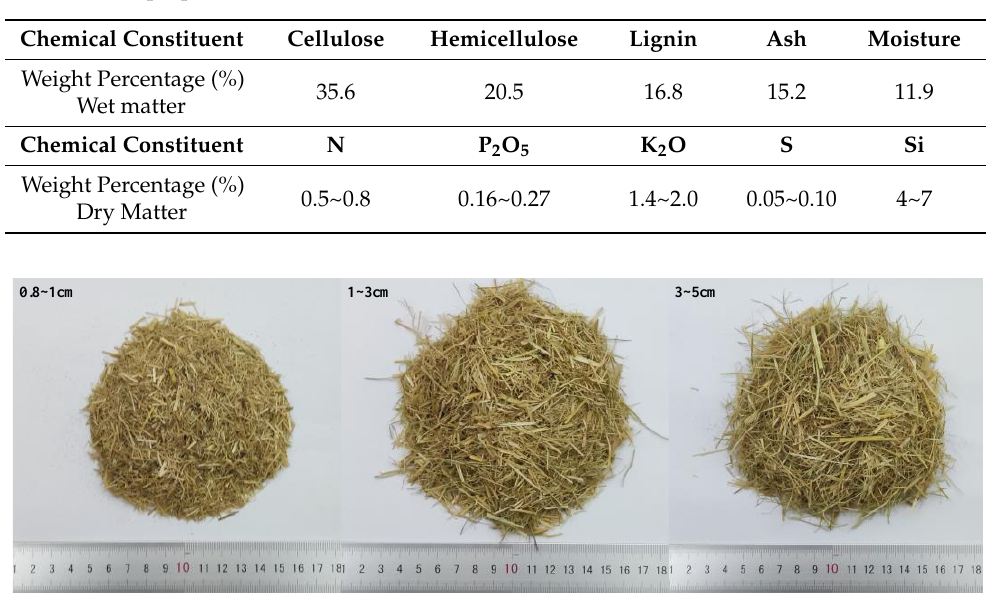
Figure 2. The morphology of RS fibers. Table 3. Main properties of RS fibers [27,33].